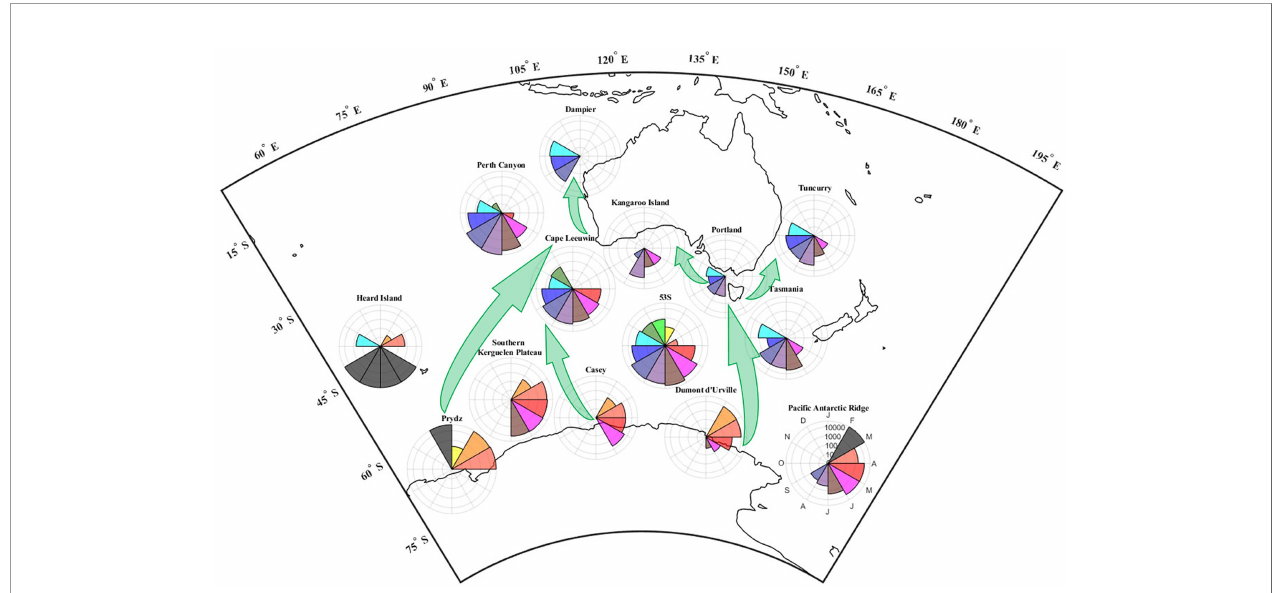
FIGURE 5 | Map of the seasons of the fi n whale in Antarctic, Sub-Antarctic and Australian waters. Polar histograms display the mean ‘ continuous ’ pulse count by month (i.e., number of pulses counted every month, normalised by the DC, and averaged over multiple recording years). Concentric circles correspond to pulse count on a logarithmic scale (10, 100, 1000, 10 000 counts). Polar segments correspond to the months of a year, with January pointing upwards and the following months arranged clock-wise. Grey segments identify months when no recorders were deployed. White segments identify months with recordings but no fi n whale pulses. Green arrows highlight the suggested northern migration pathways fi n whales take between Antarctic and Australian waters and we assume same paths for the southern migration. For better legibility, polar plots are not positioned right on top of all recorder sites, but have been moved and represent regional trends; see Figure 1 for exact site locations. Equidistant Conic Projection used.